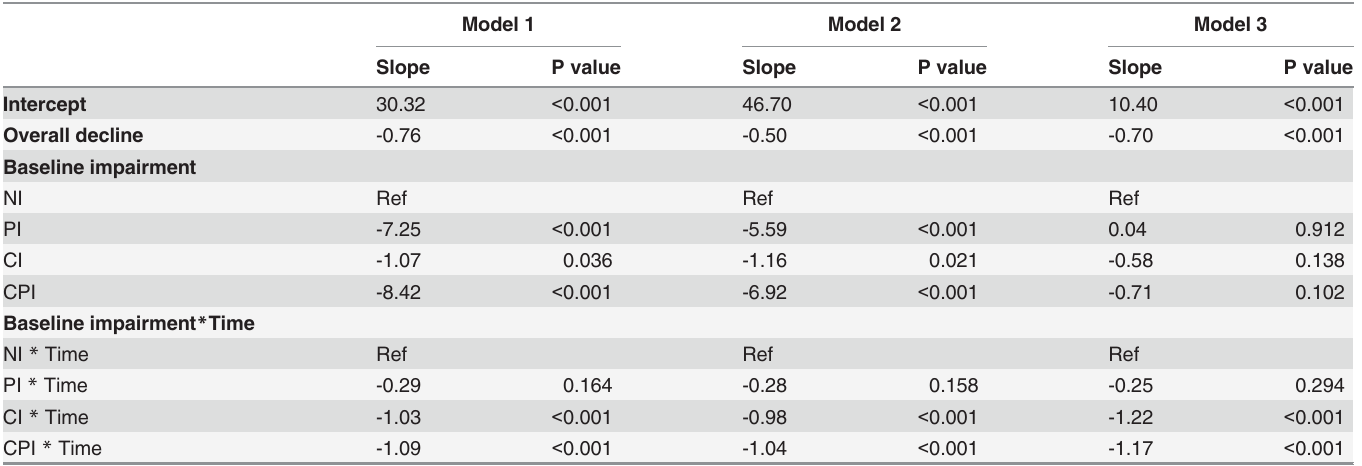
Table 2. Rate of decline in physical performance by baseline impairment